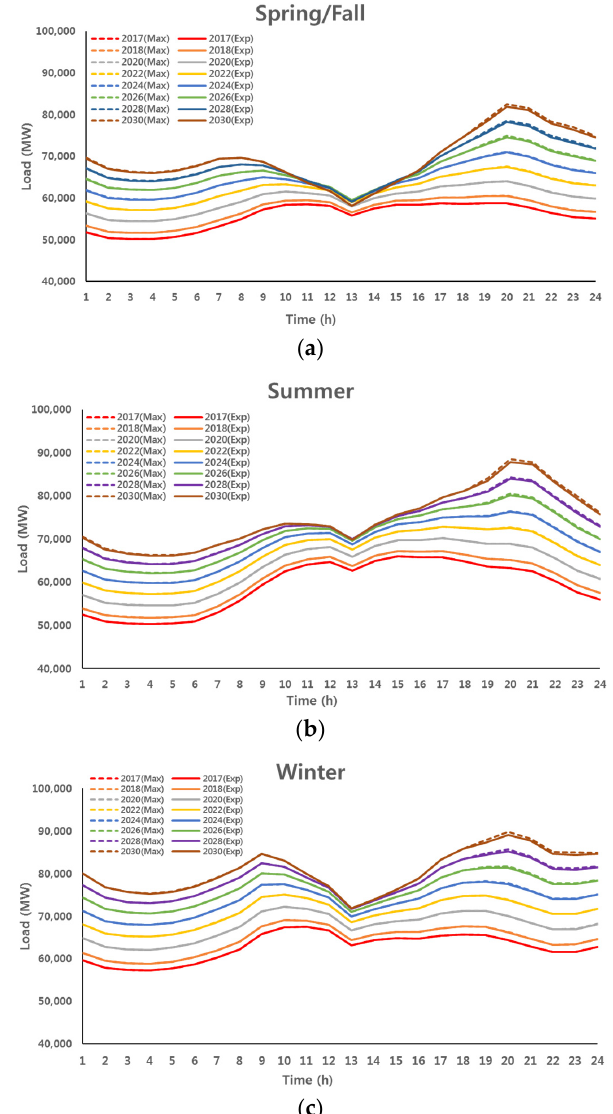
Figure 10. Seasonal predicted net load curves in each year from 2017 to 2030 considering PV and EV penetration: ( a ) for spring and fall; ( b ) for summer; and ( c ) for winter.